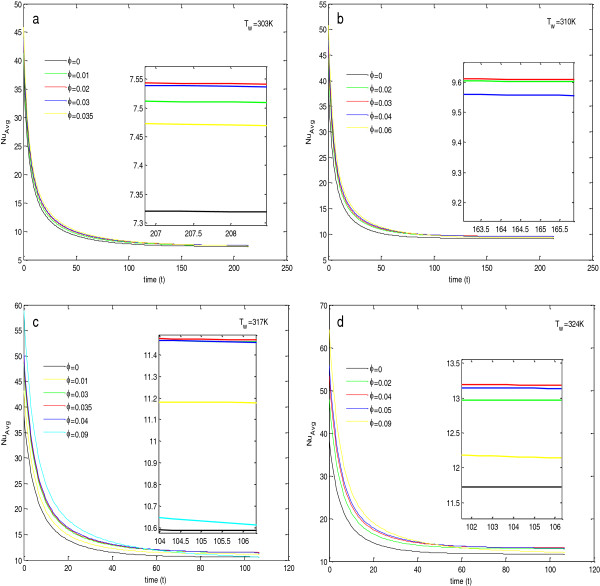
Average Nusselt numbers for Al2O3 + H2O nanofluid at(a,b,c,d)different wall temperatures.